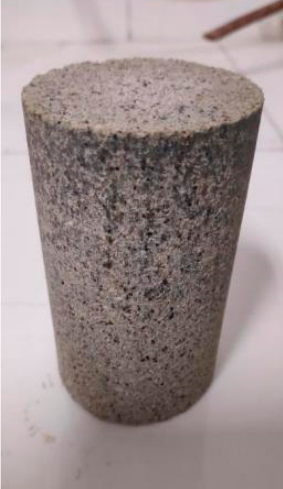
Figure 9. A sample that has undergone a wet–dry cycle.